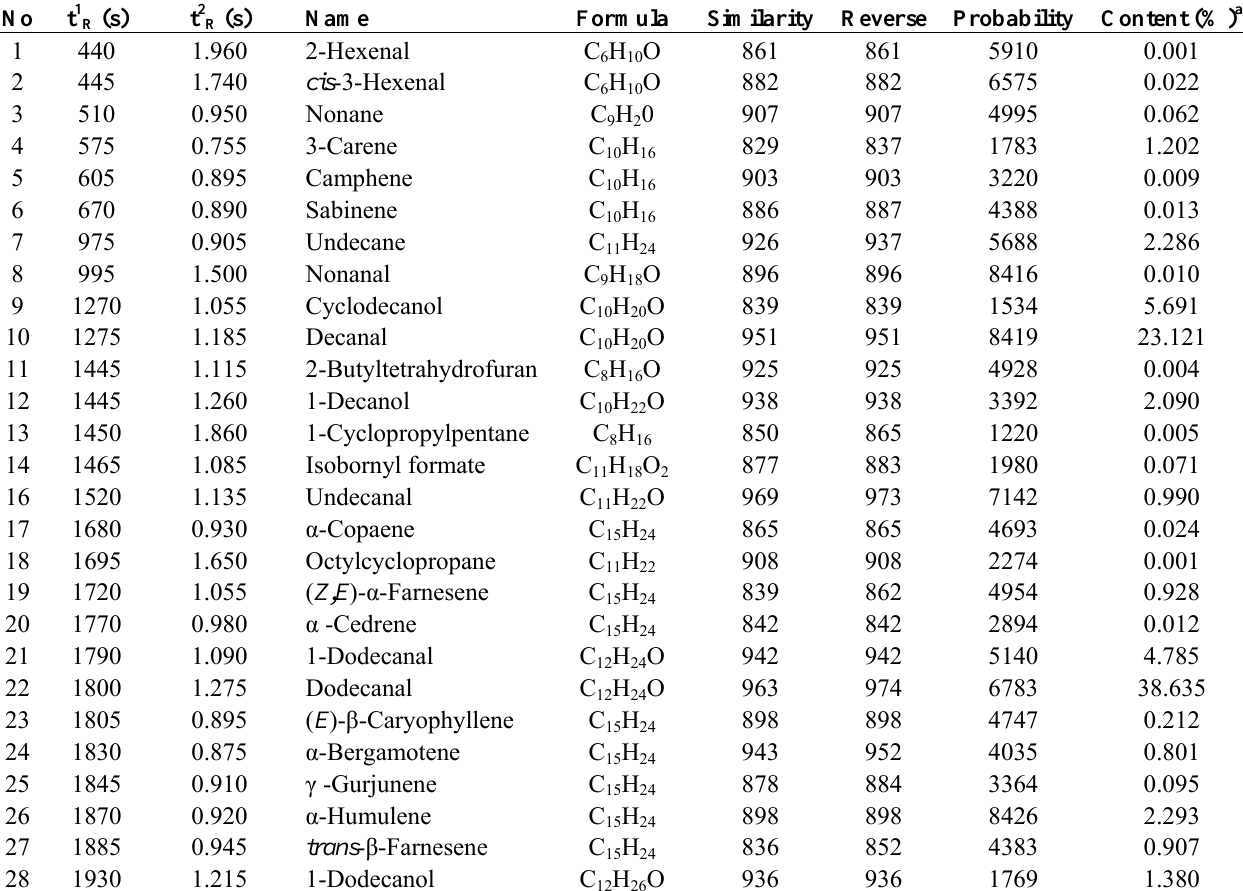
Table 2. Compounds identified in the essential oil of kesum using two-dimensional